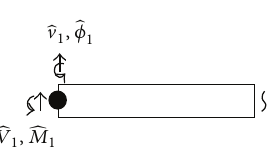
Figure 3: One-node throw-off beam spectral element.